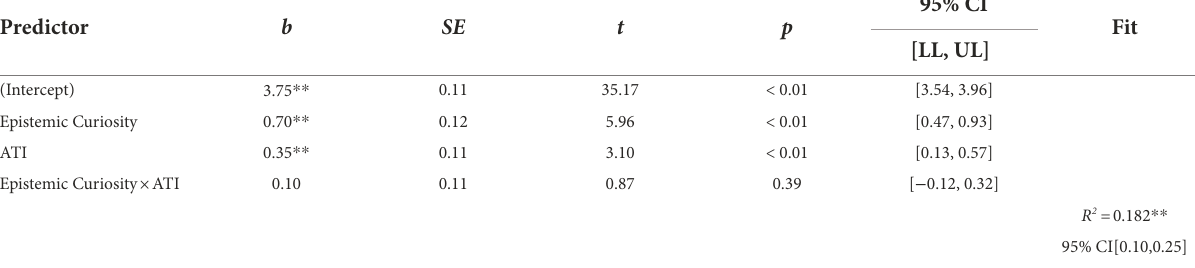
TABLE 8 Moderated regression results using entrepreneurial intentions as the criterion.